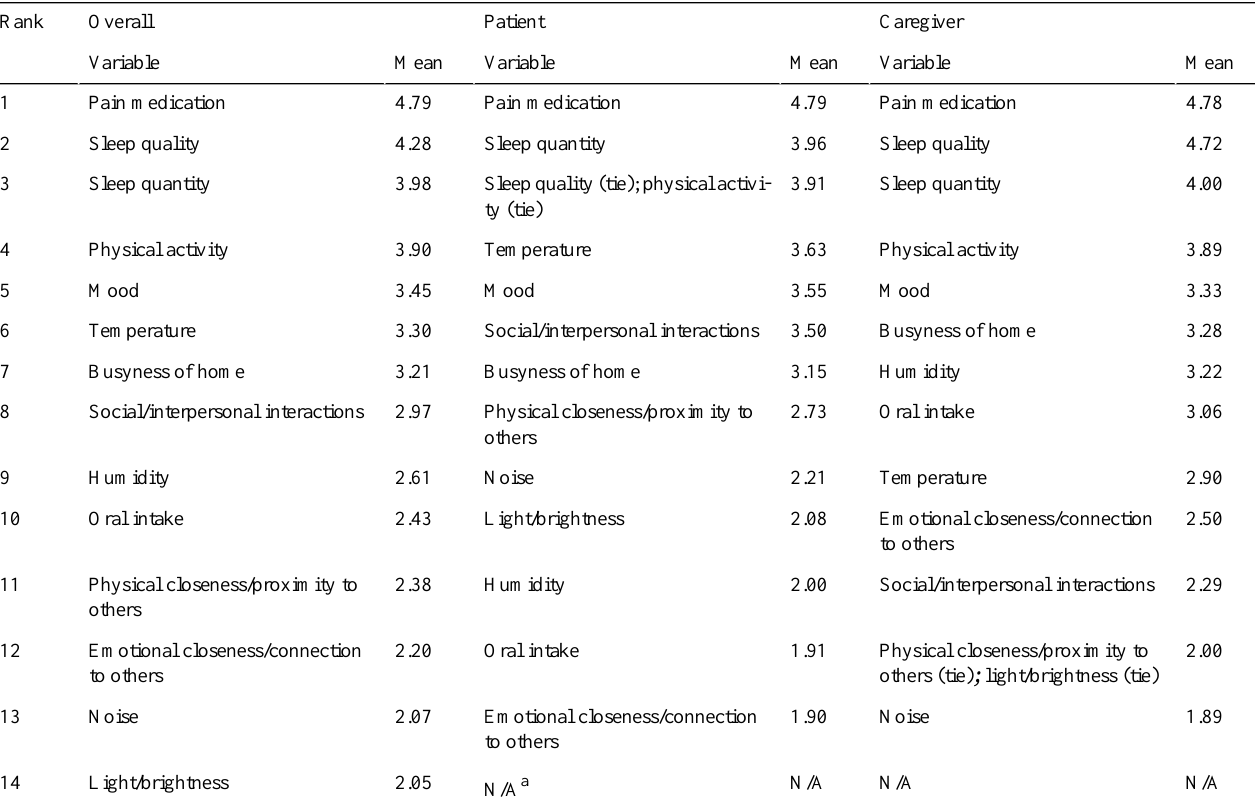
Table 4. Rank order of individual variable impact means (0=no impact; 5=highest impact) on patient’s